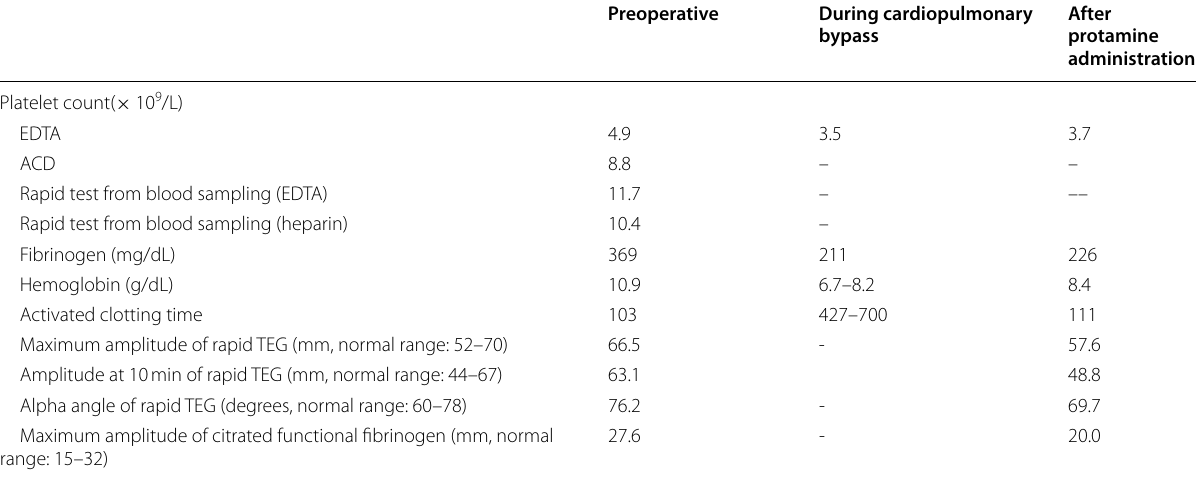
Table 1 Perioperative laboratory tests and TEG6s results at three time